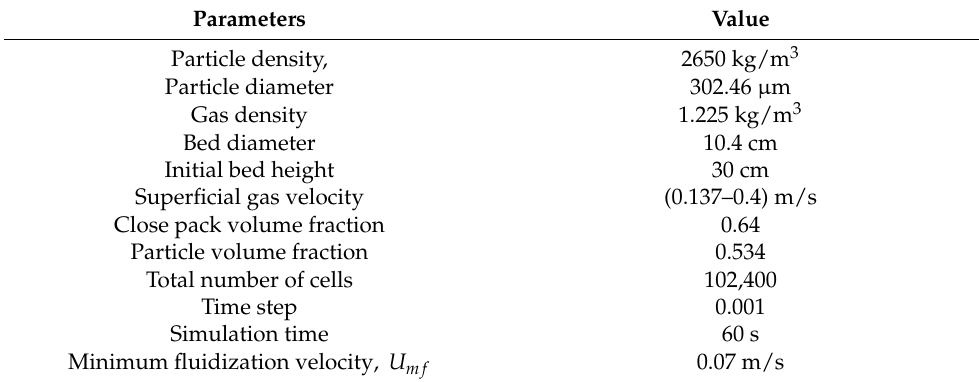
Table 1. Simulation parameters used for the model development in a BFB